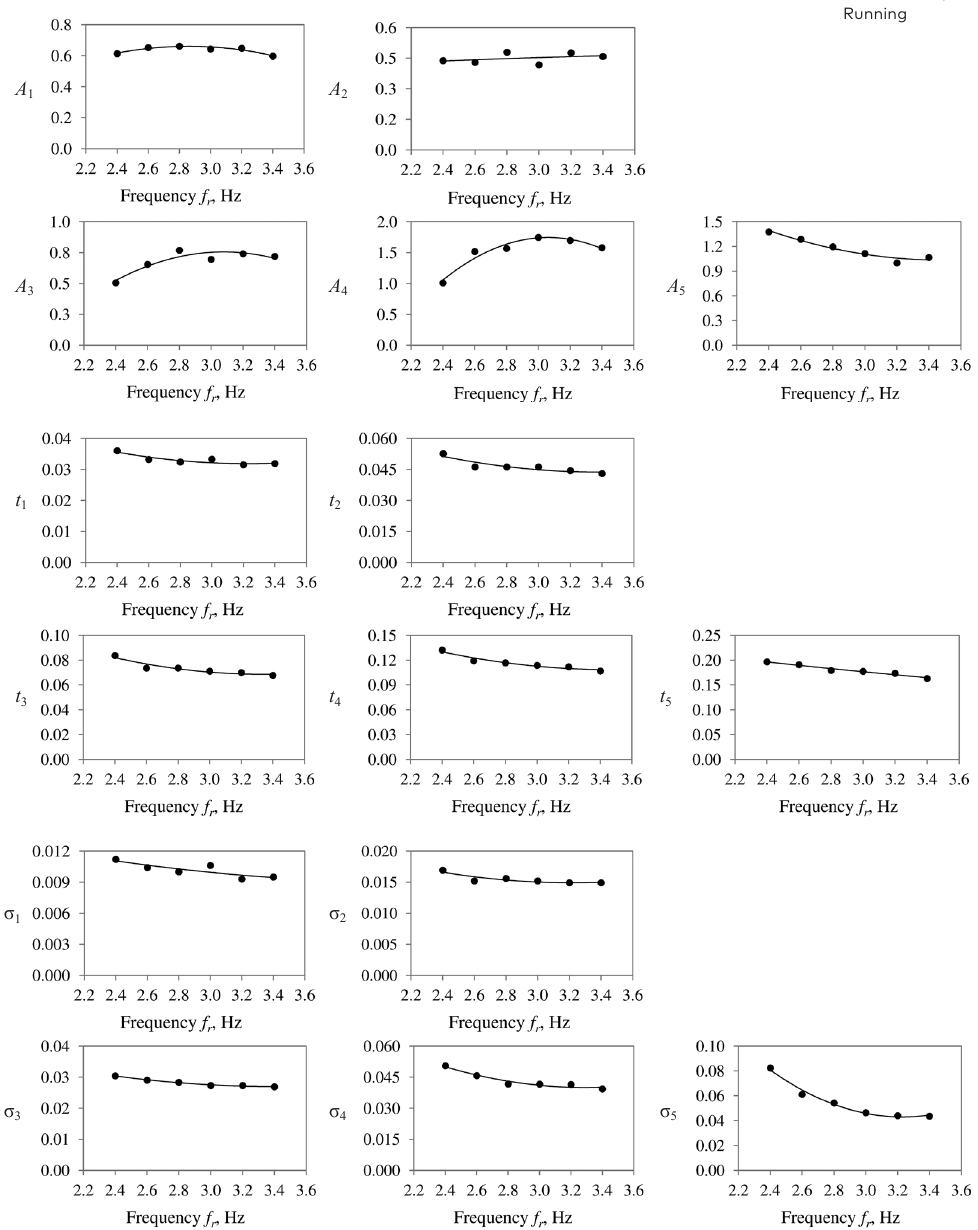
Figure 13. Variability of the Gaussian function parameters A p , t p , considered as a function of the running frequency f r (black dots – parameters of templates presented in Tables 4–9; solid line – trend line determined